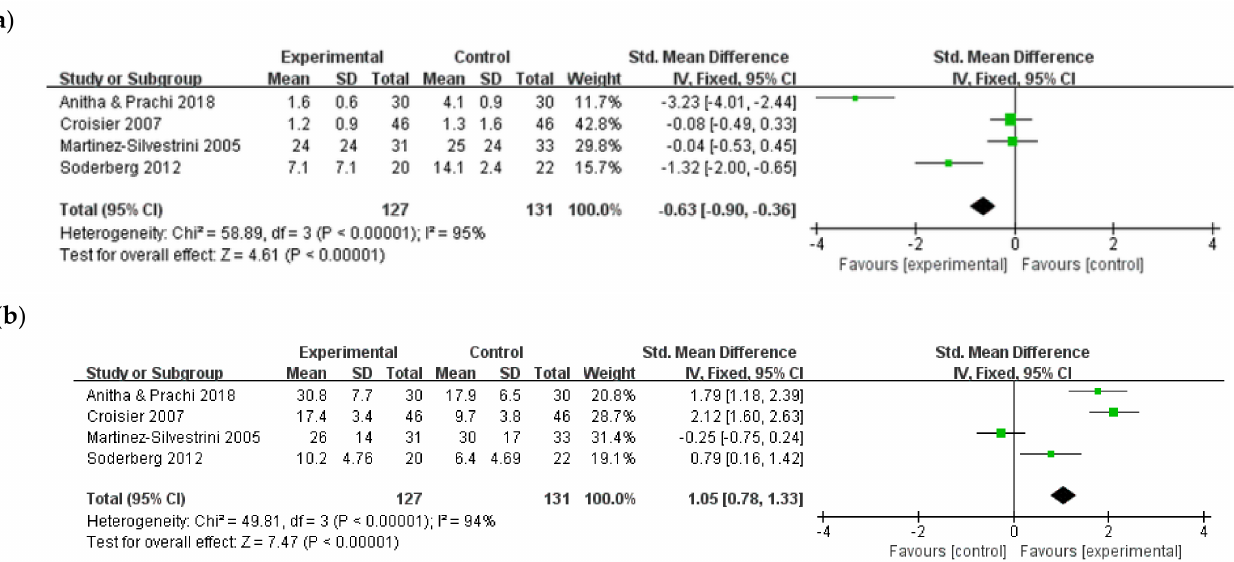
Figure 3. Add-on effects of eccentric exercise with adjuvant therapy on ( a ) pain intensity and ( b ) muscles strength in lateral elbow